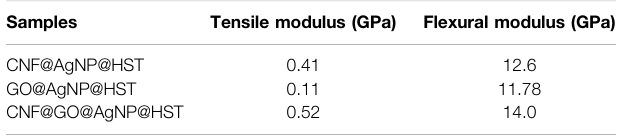
TABLE 3 | Antiviral activity of the tested